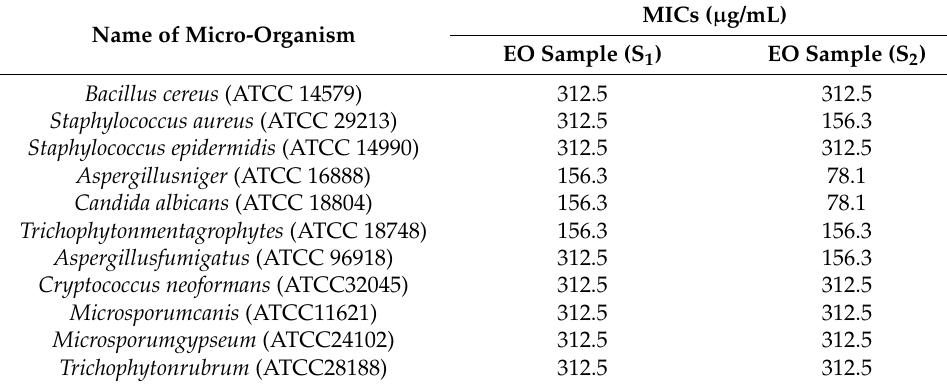
Table 4. Minimum inhibitory concentrations (MICs) of O. majorana essential oils against tested bacterial and fungal